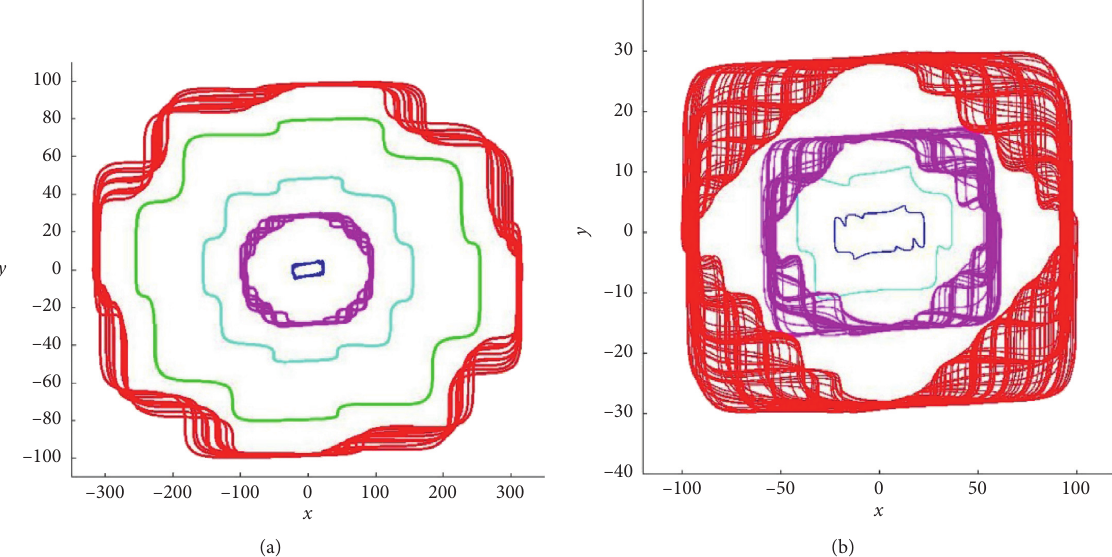
Figure 6: Trajectories for different sets of parameters and different initial values. (a) A � 2 , w � 0 . 5, and the initial values are set ( 0 , 2 ) , ( 0 , 30 ) , ( 0 , 45 ) , ( 0 , 80 ) , and ( 0 , 150 ) . (b) A � 1 ,w � 0 . 5, and the initial values are set ( 0 , 2 ) , ( 0 , 9 ) , ( 0 , 15 ) , and ( 0 , 27 ) .